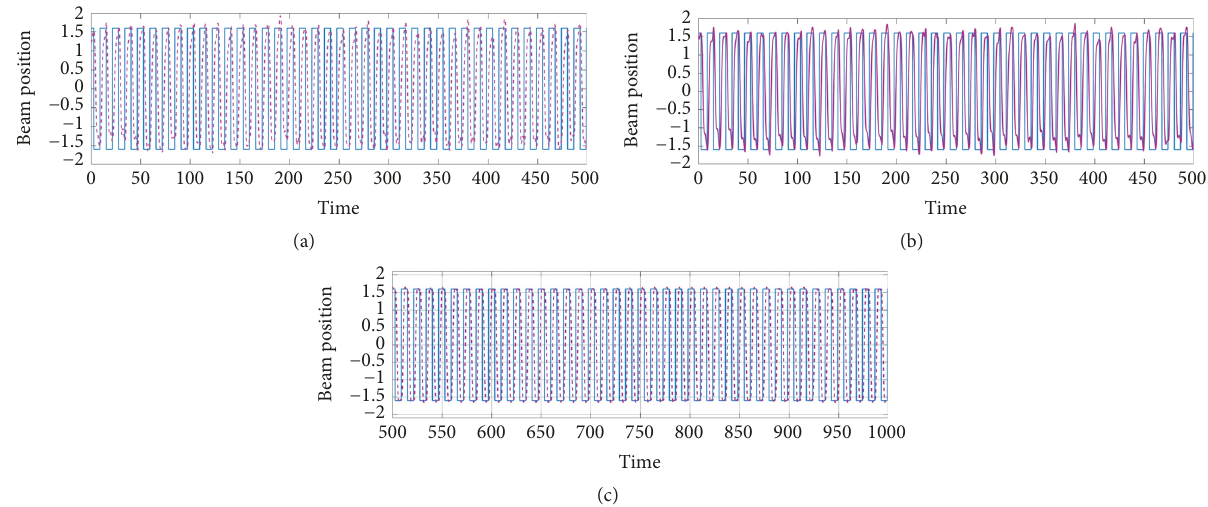
Figure 14: Behavior of equilibrium for each method with